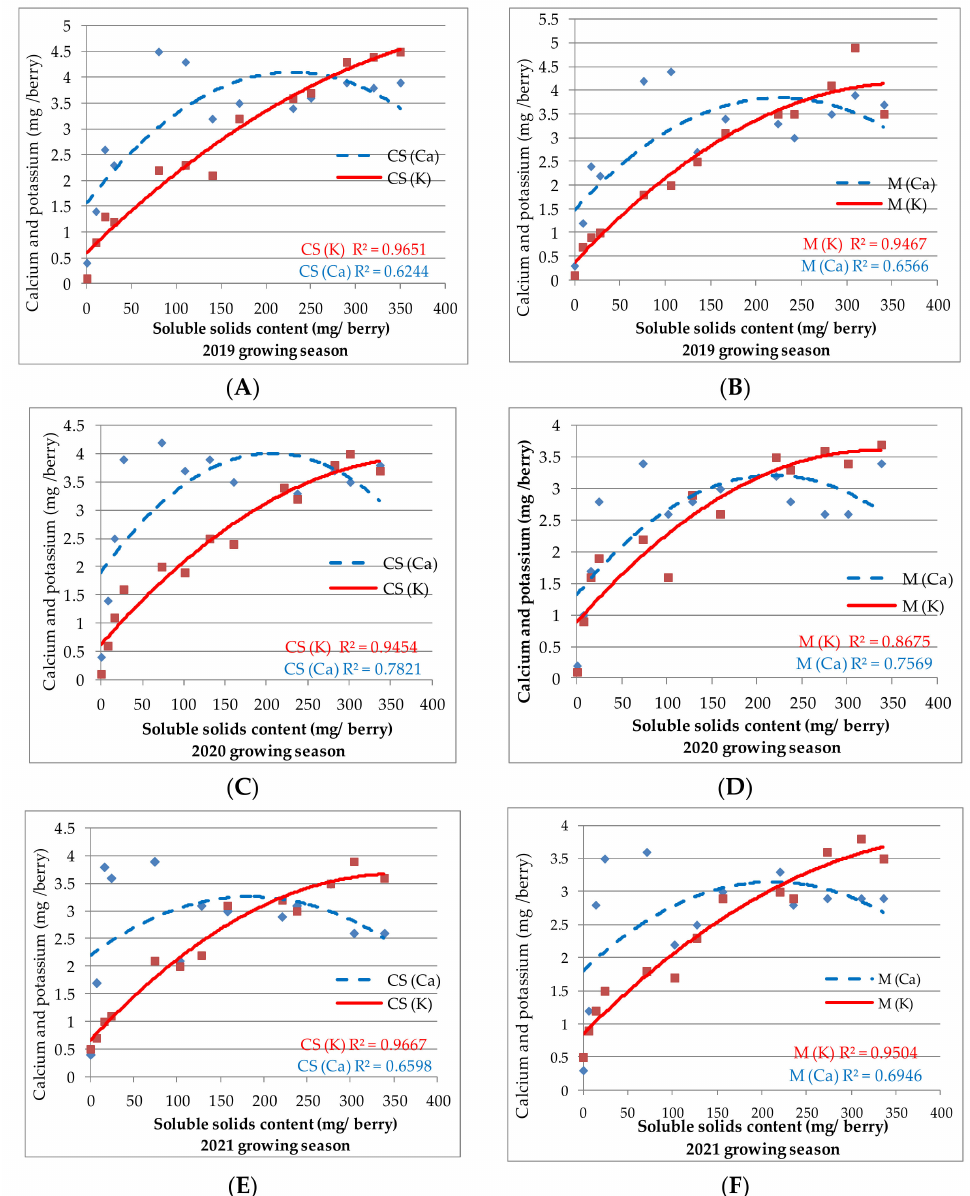
Figure 5. Sugar (soluble solids) accumulation and relationship with K and Ca in ‘Cabernet Sauvignon’ (CS) and ‘Merlot’ (M) berries in the 2019–2021 growing seasons, from flowering to maturity. To represent the relationships between DAF, sugar, Ca, and K accumulation in the CS and M berries during the 2019–2021 growing seasons, a scatterplot with a trend line of different colour and dash type was drawn. ( A , C , E —K in CS berry; —Ca in CS berry; B , D , F —K in M berry; —Ca in M